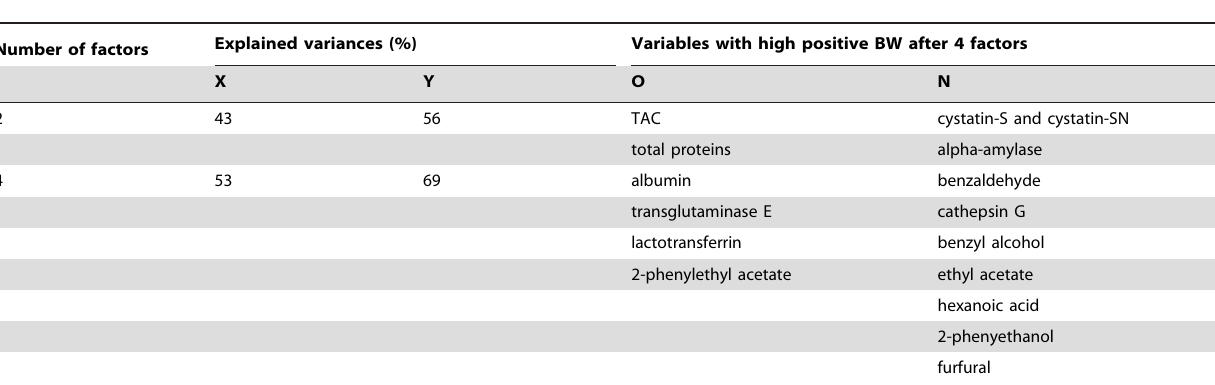
Table 4. Relevance of the PLS-DA calibration modeling: explained variances and high positive weighted regression coefficients